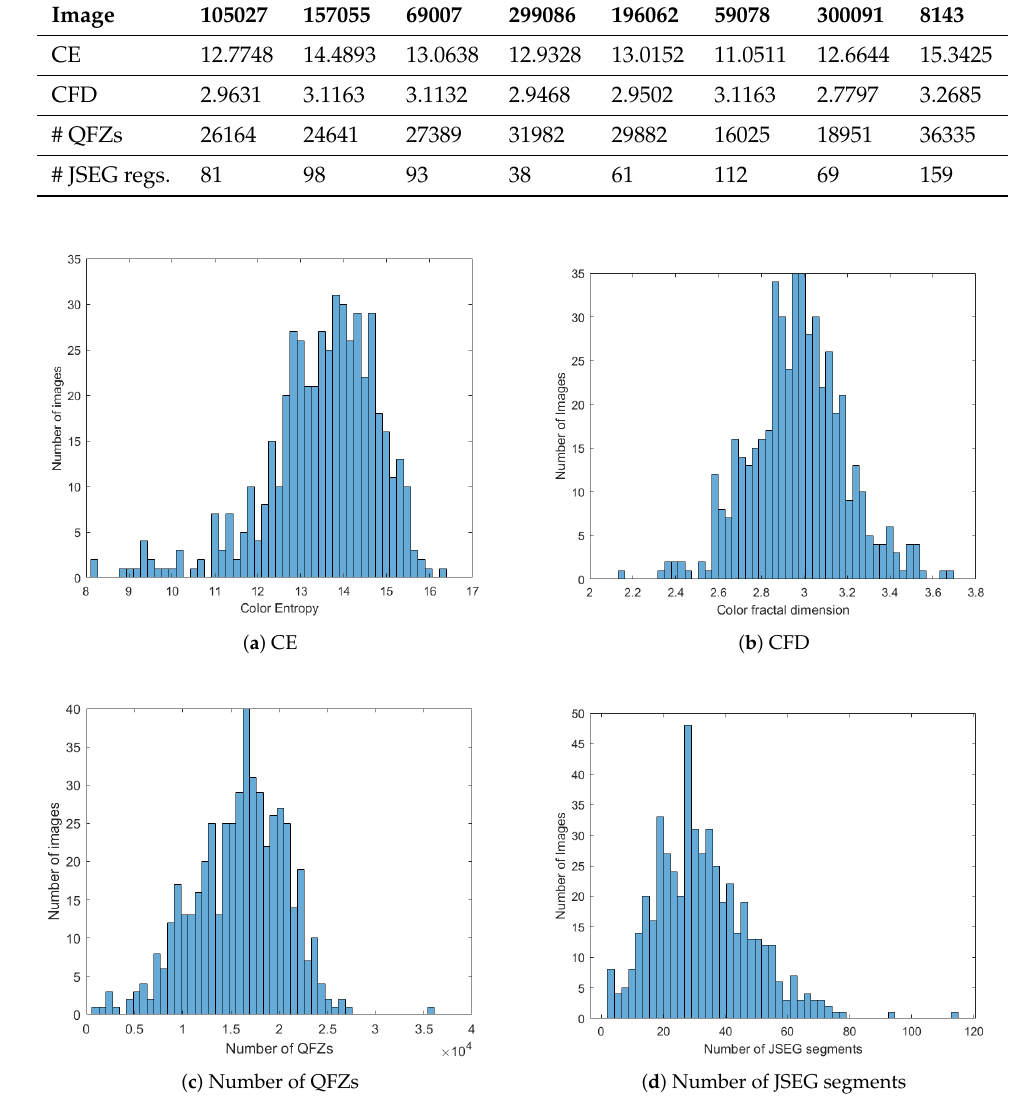
Figure 4. Histograms of CE, CFD, number of QFZs and number of JSEG segments on the BSDS500 data